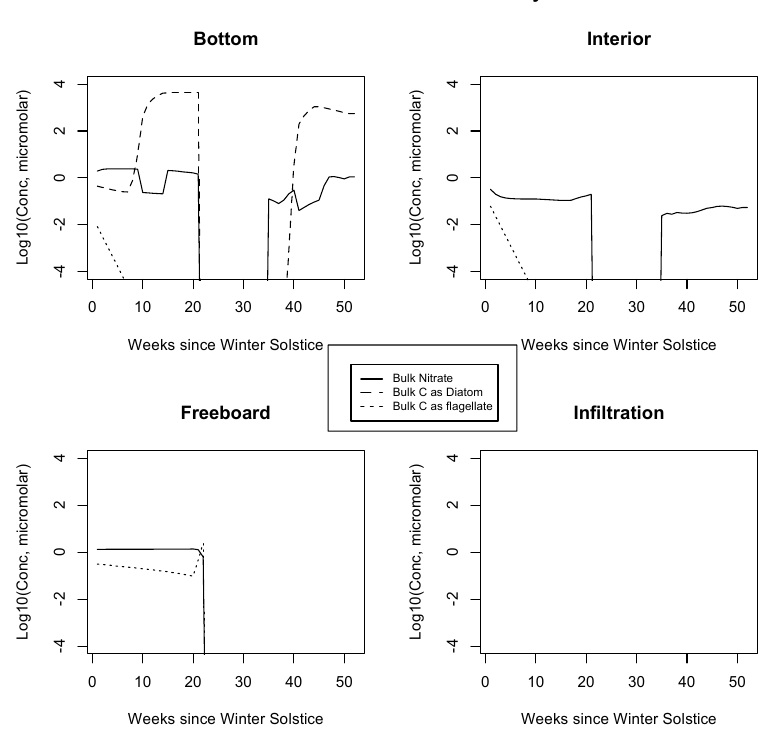
Figure 5. Beaufort Sea, caption as in Figure